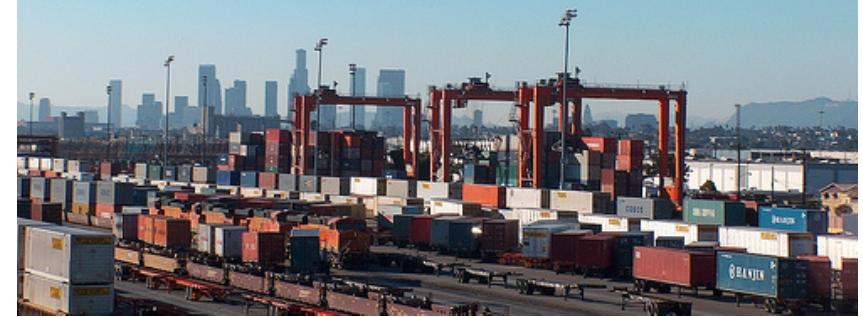
Figure 10. BNSF Hobart Yard, Commerce, CA with downtown Los Angeles in the background. Photo courtesy of Angelo